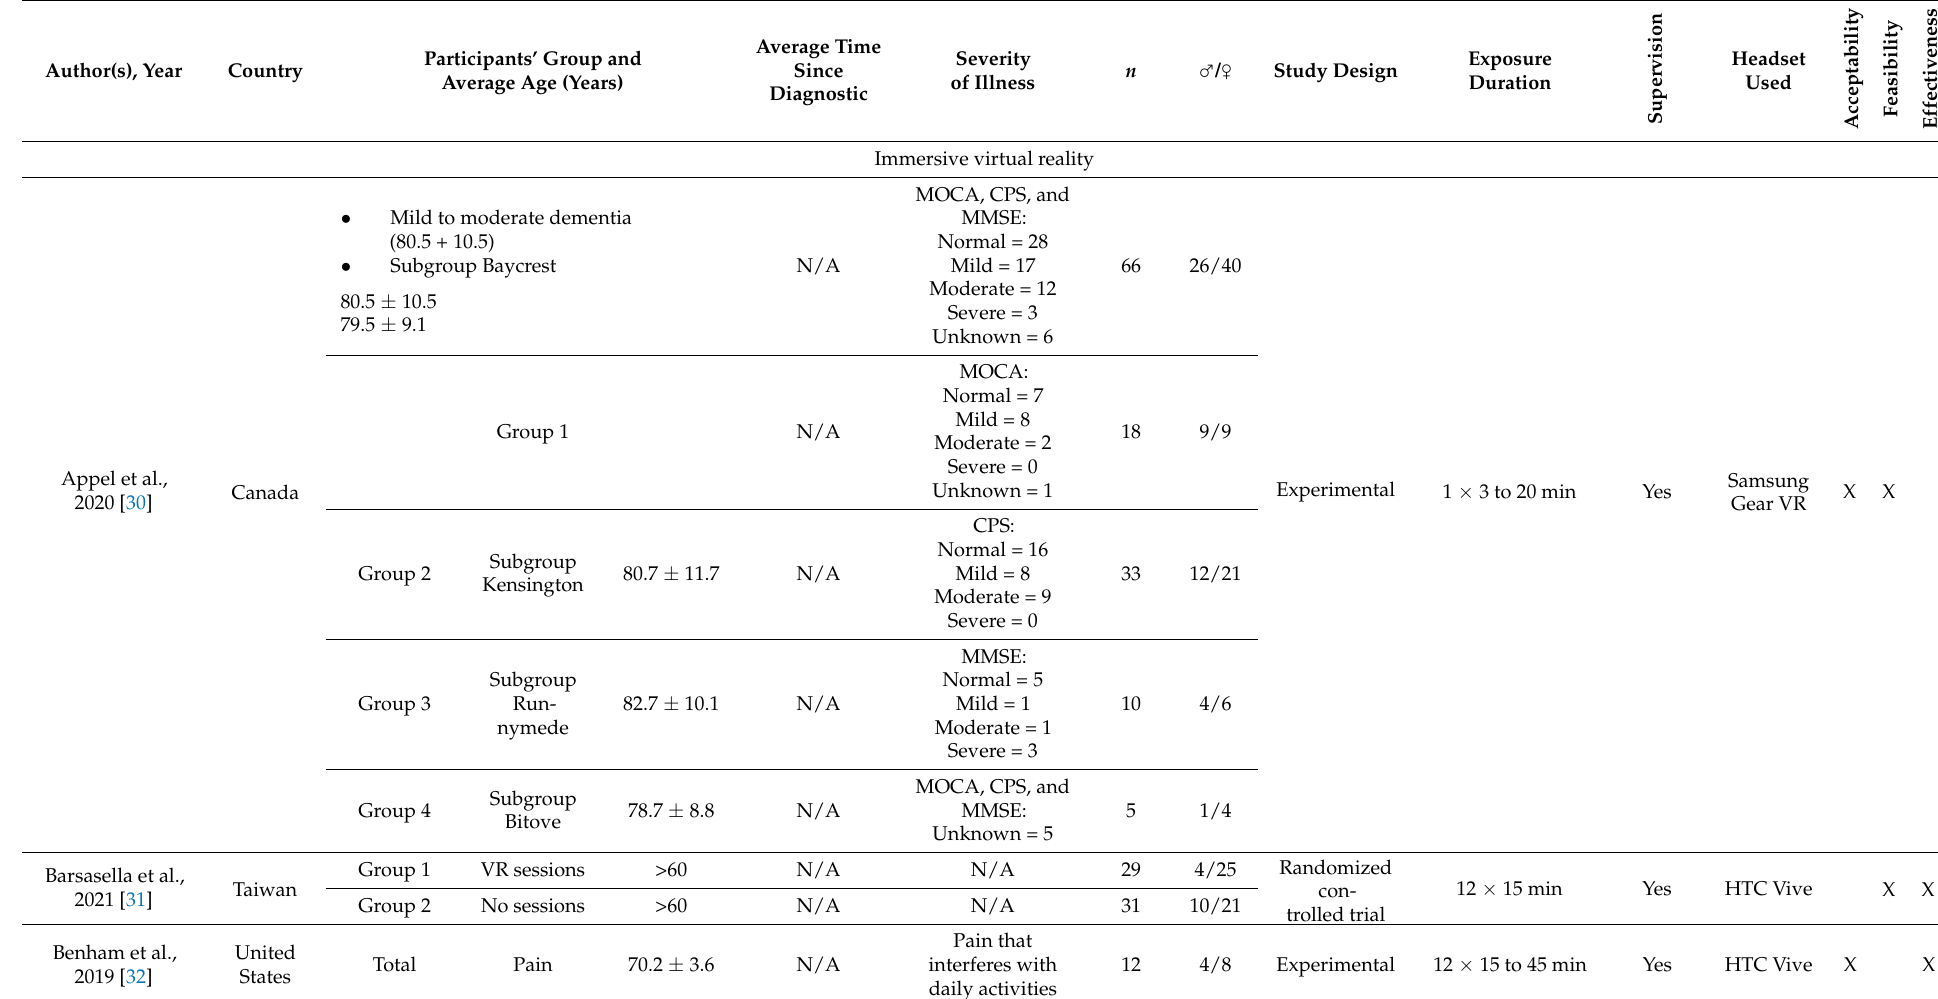
Table 1. Characteristics of the included